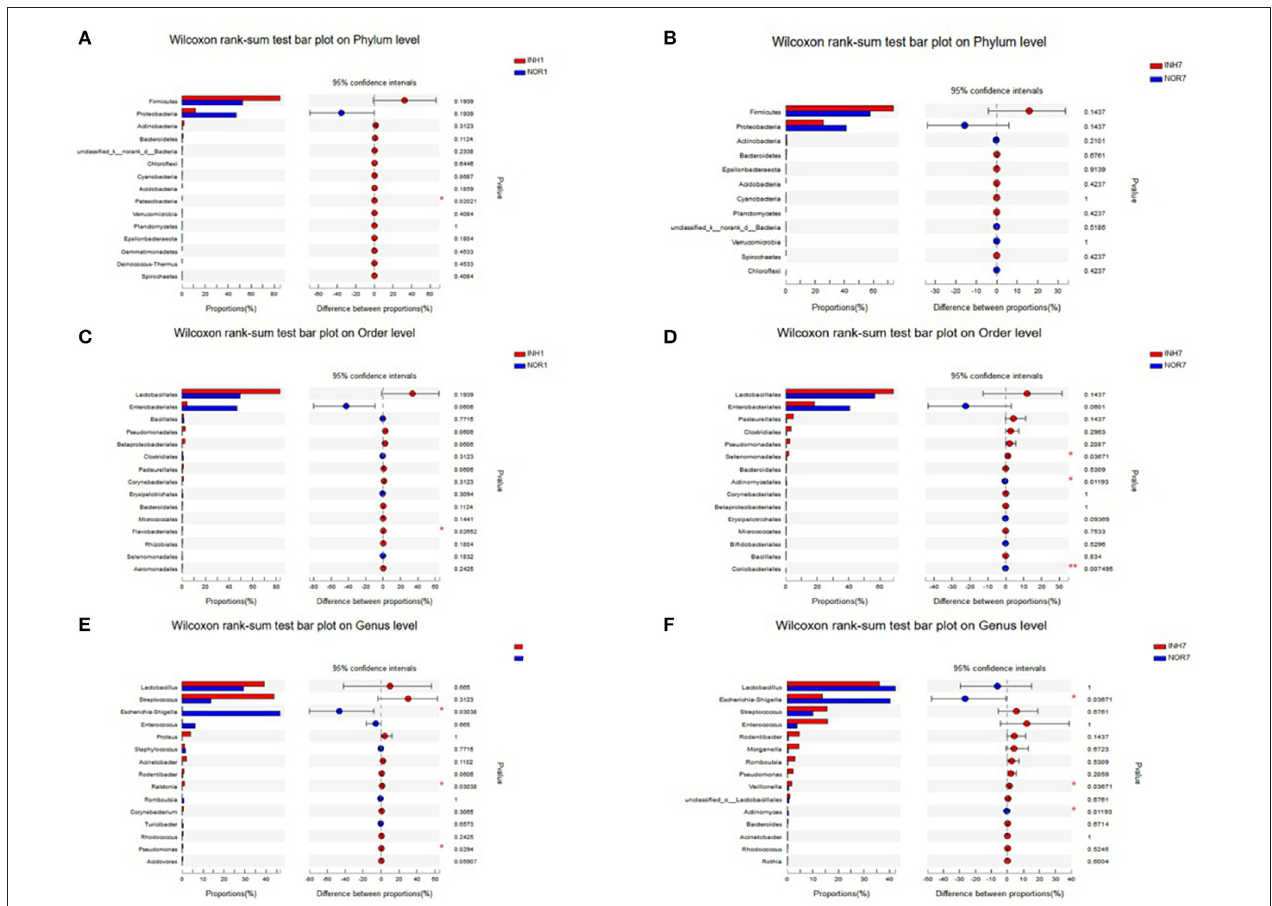
FIGURE 6 | The X-axis represents different groups, different colored boxes represent different groups, and the Y-axis represents the average relative abundance of a species in different groups. (A,B) Bar plot on Phylum level in different groups. (C,D) Bar plot on Order level in different groups. (E,F) Bar plot on Genus level in different